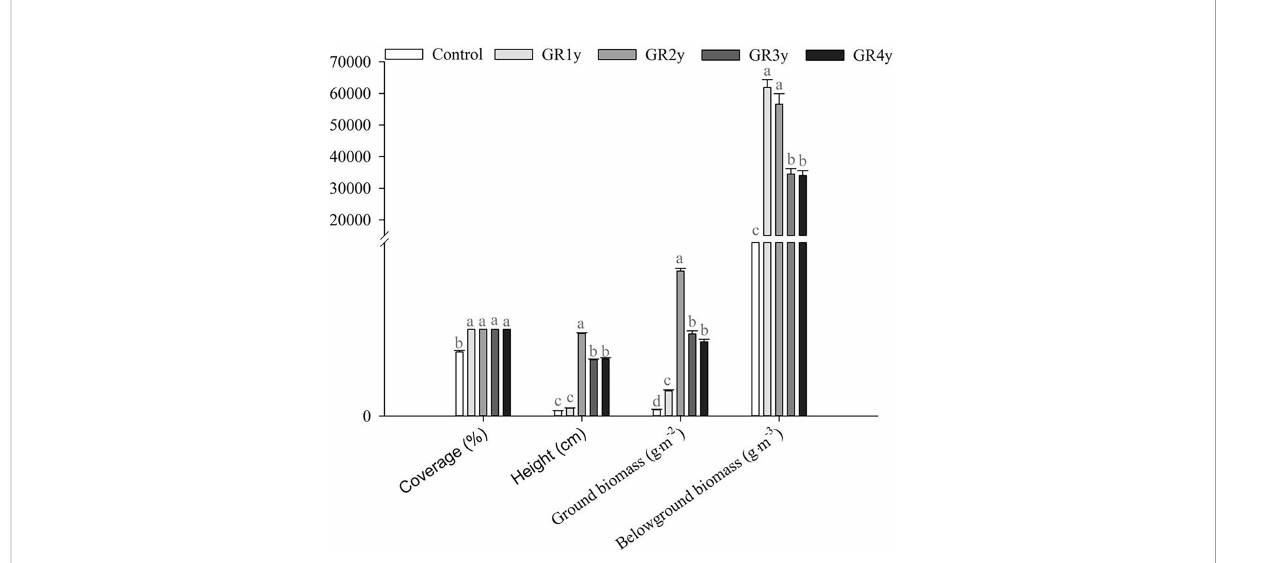
FIGURE 1 Effect of grazing rest during the spring regreening period on the quantity characteristics of the degraded alpine meadow vegetation. Bars represent SEs. Common letters above columns indicate no signi fi cant difference at P = .05. GR 1y, GR 2y, GR 3y, and GR 4y mean grazing rest for 1, 2, 3, and 4 years,